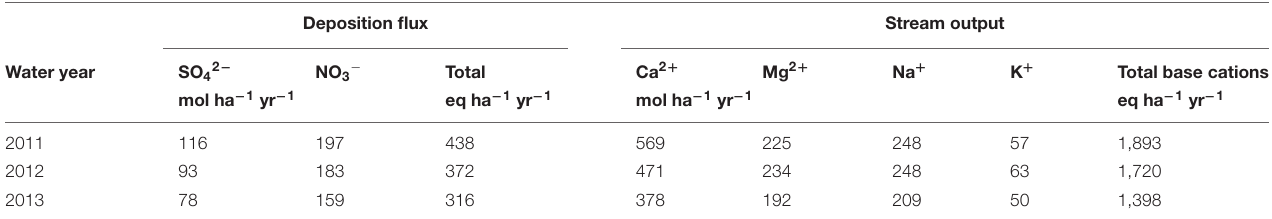
TABLE 5 | Average annual deposition fluxes of SO 42 − and NO 3 − and average annual stream output of base cations for all watersheds. Deposition flux Stream